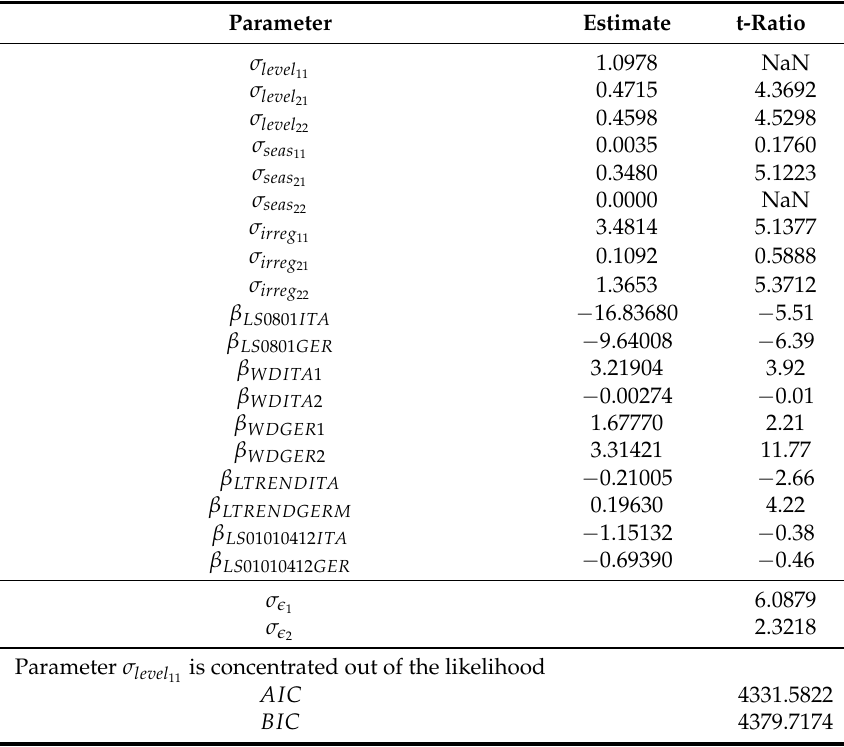
Table A14. Endogenous variables: IPI t durable goods TTMI t in Germany.